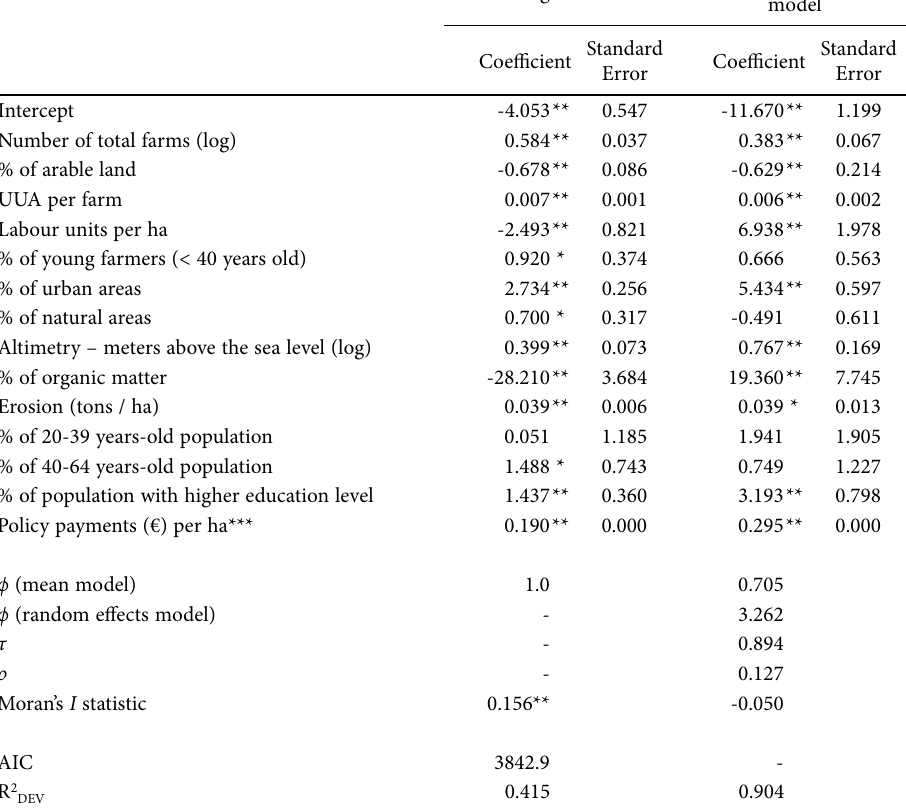
Table 3 . Estimated parameters for the Poisson regression model and the quasi-Poisson CAR-HGLM mo- del based on a 3-km-size grid, Marche